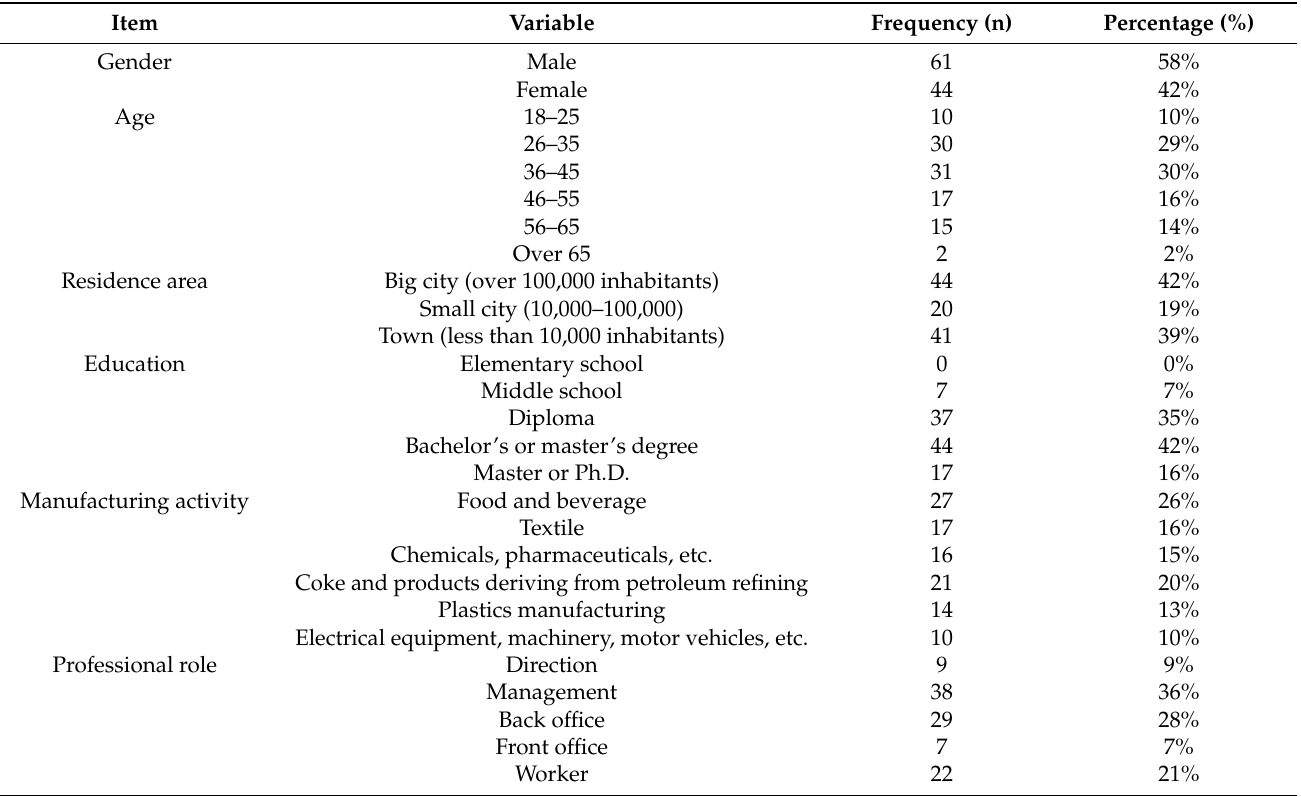
Table 4. Sociodemographic